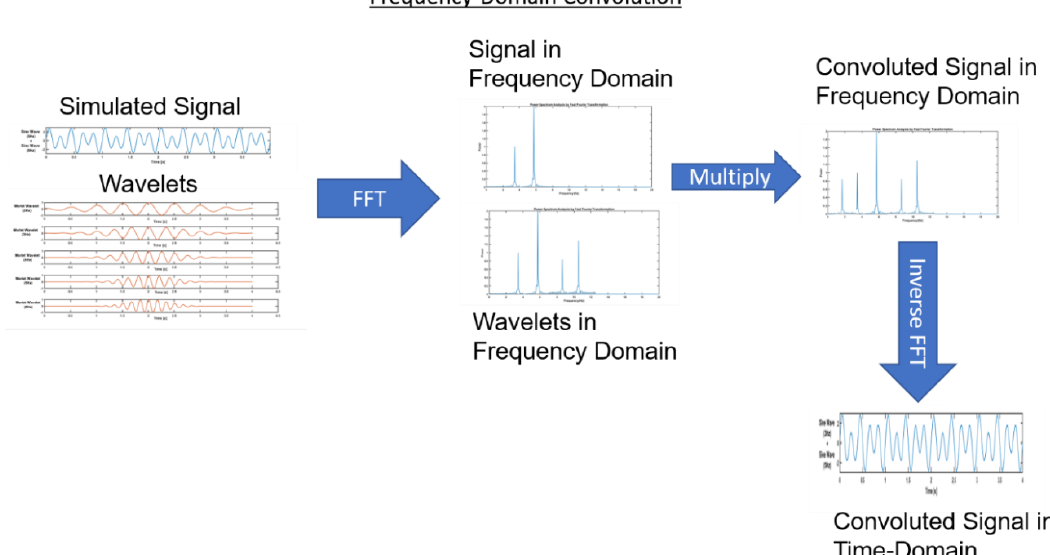
Figure 9. Illustration of the convolution theorem and frequency-domain multiplication.